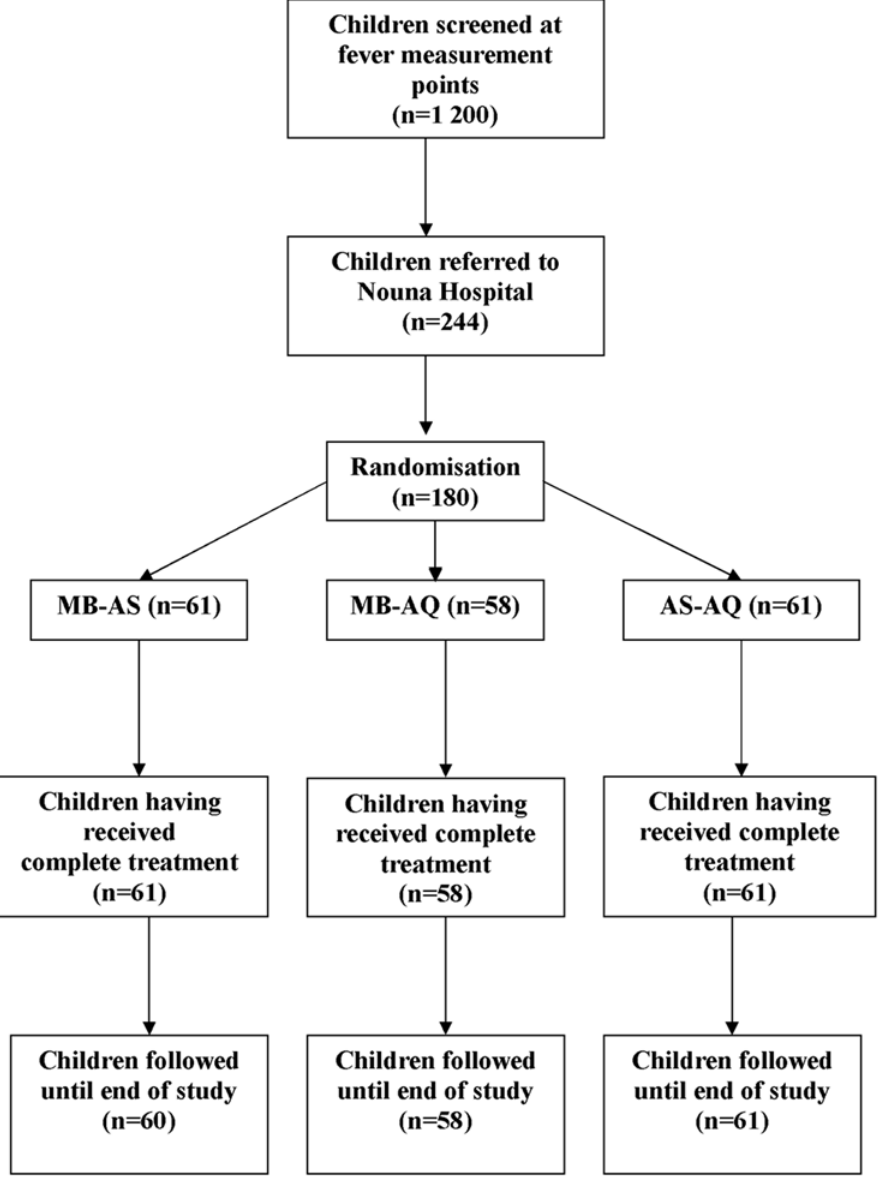
Figure 1. Flow chart of study patients. Explanations: (1) Of 244 children assessed for eligibility, 64 were excluded because of not meeting inclusion criteria; (2) In group MB-AS, one child was lost to follow-up because of family out-migration after day 7; (3) all children followed up until the end of the study were included into the analysis